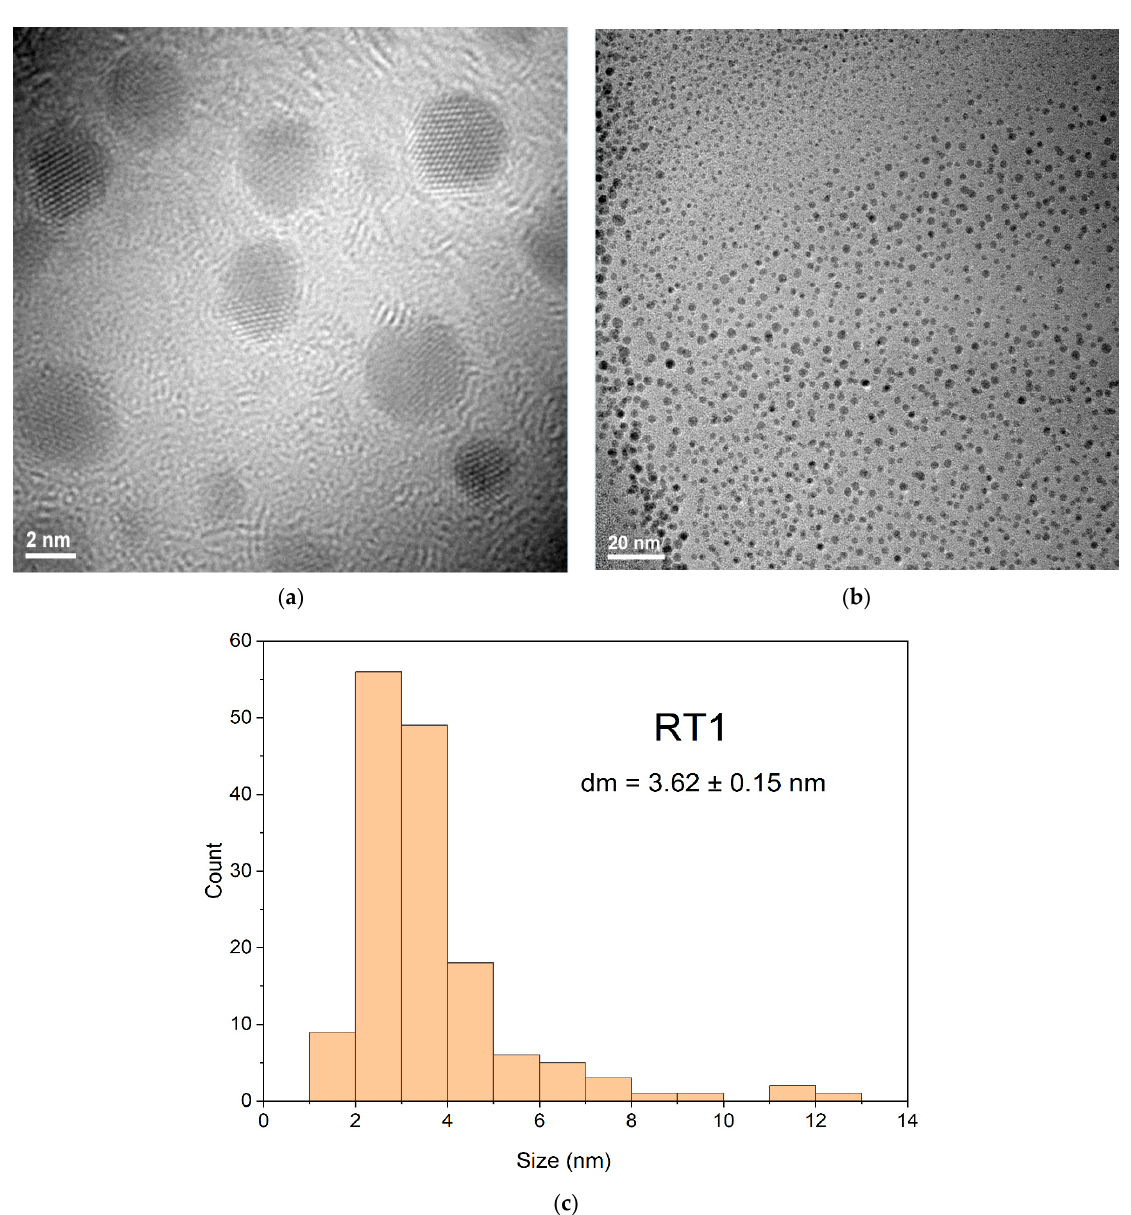
Figure 6. TEM images of AgNPs sample coded RT1 at two different magnifications ( a , b ) and the appropriate histogram ( c ).